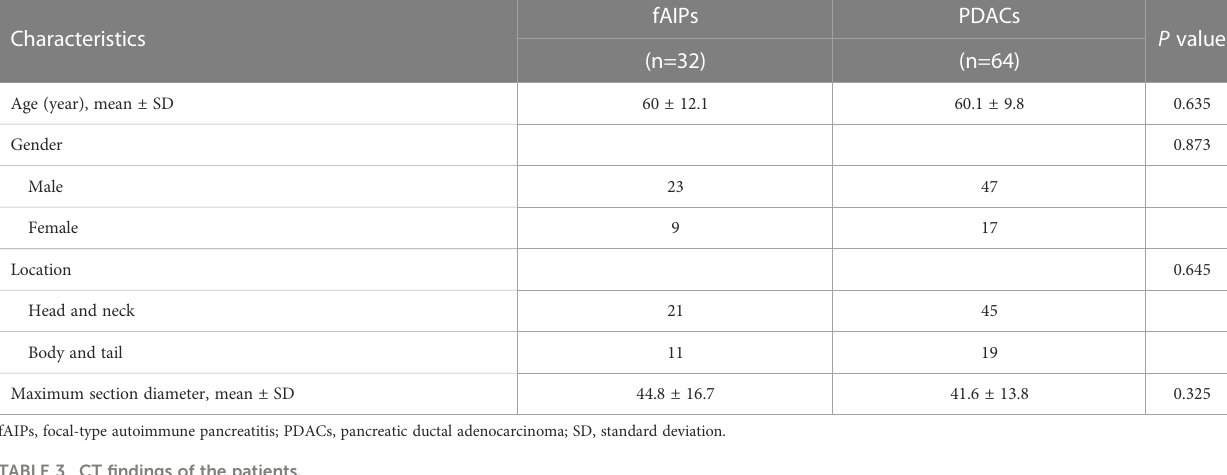
TABLE 3 CT fi ndings of the patients.